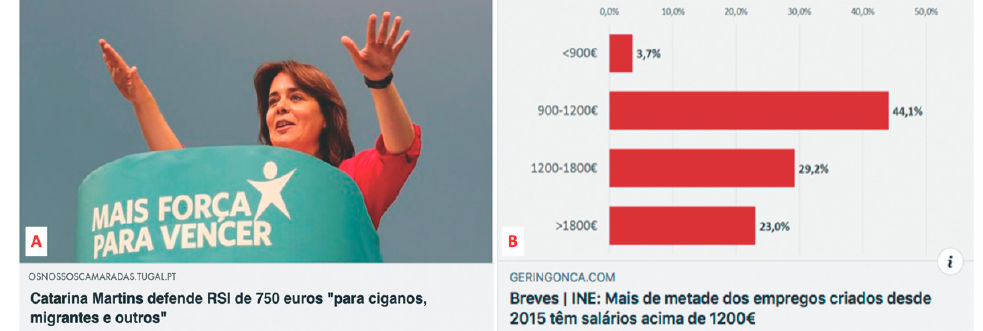
Figure 1. Example of fake news targeted to right ( A ) and left ( B ) audiences used in the study. Note: A —Catarina Martins defends a basic income of 750 euros “for gypsies, migrants and others” Figure A explores social prejudice toward the Roma community. The Roma community has been a victim of right-wing populist rhetoric, based on the stereotype that “people don’t work because they don’t want to” and that they are living on state benefits. The fake story indicates that a leader of the left party defends a higher state benefit, even higher than the Portuguese minimum wage. B —Brief | Statistics Portugal: More than half of the jobs created since 2015 have salaries above 1200 €. Figure B reports that half of the jobs that have been created since 2015 have salaries above 1200 euros. In 2015, Portugal came to be governed by a left-wing party (PS) that succeeded a right-wing government that was marked by the Troika’s economic rescue, low wages, unemployment and precariousness. Source: The fake headlines were edited by the authors and adapted from the Polígrafo: A (https://bit.ly/3cP4PcB, accessed on 25 May 2021) and B (https://bit.ly/3a0jrE7, accessed on 25 May 2021).